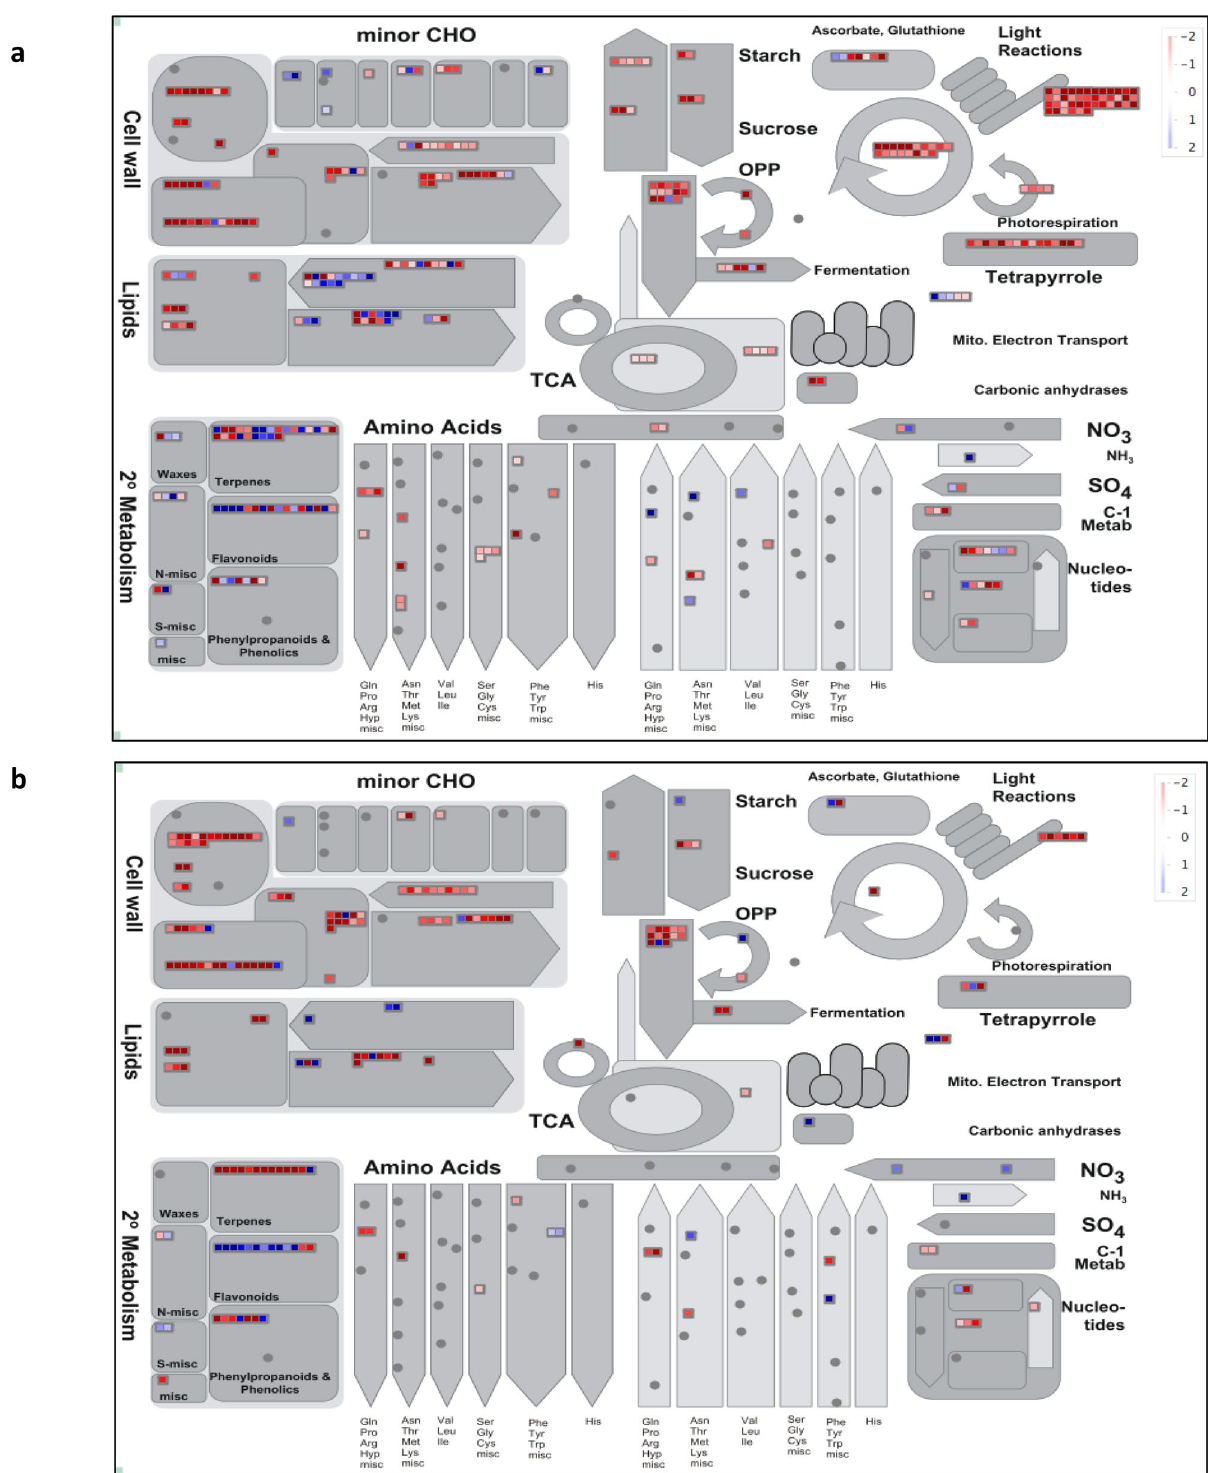
Figure 5. Mapman analysis of differentially expressed genes related to various metabolic processes in ( a ) Salinas, ( b ) UC genotypes. Red squares represent genes that were significantly down-regulated; blue squares represent genes that were significantly